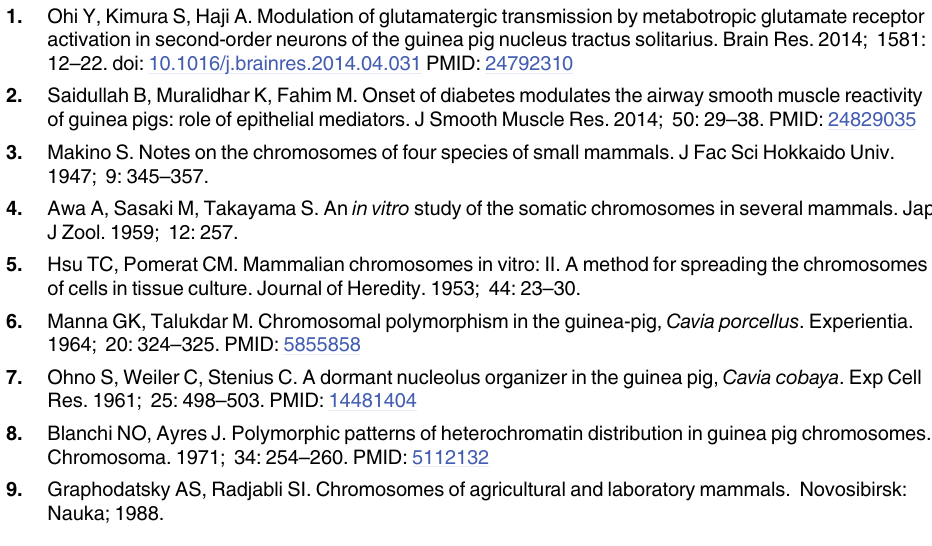
S1 Fig. The G-banded ideogram complete with band nomenclature. p and q — short and long arms of chromosome, respectively. Bigger figures mark segments, smaller — separate